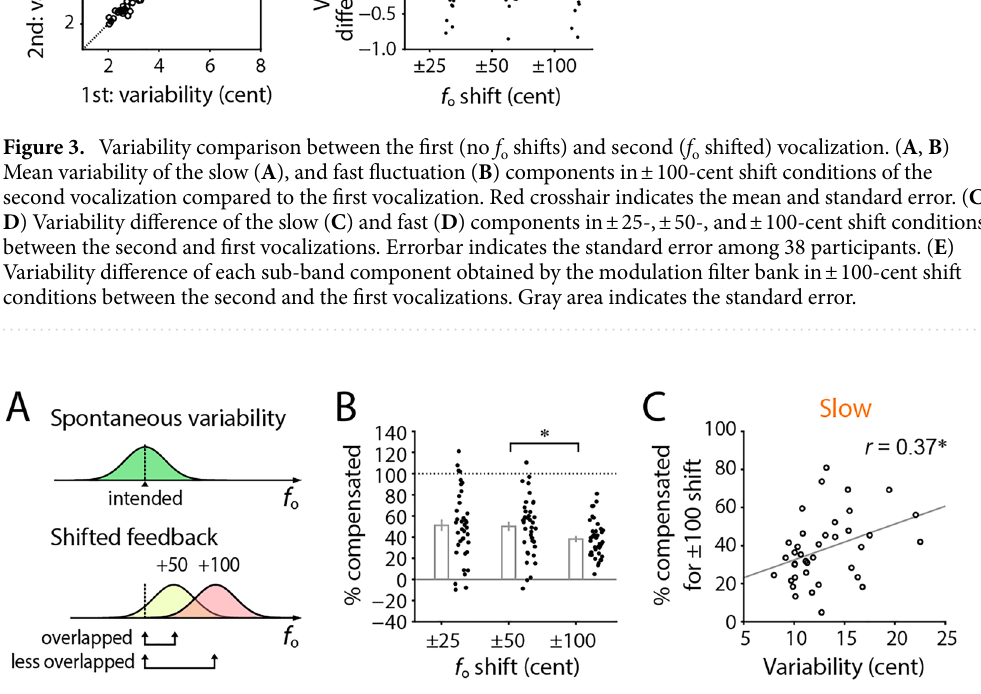
Figure 4. Decreased compensation for larger f o shifts. ( A ) Schematic drawing of normalized distributions for the spontaneous f o variability (upper) and shifted versions of its feedback after the introduction of + 50 and + 100 cent shifts (lower). Given a certain amount of variability, originally intended f o will not overlap well with the distribution for large f o shifts, i.e., the large f o shifts will be outside of the motor exploration range. This can be expected to reduce the compensation ratio for that condition. ( B ) Percent amount of compensatory responses against different amounts of f o shift (25, 50, and 100 cents). The vocal responses to positive f o shifts were sign- inverted and averaged with that to negative shift conditions. Each dot indicates one individual participant. Error bar shows the standard error ( n = 38). Asterisk (*) indicates statistically significant difference ( p < 0.05 in post hoc comparisons with Tukey–Kramer correction). ( C ) Correlation between the compensation ratio for the 100-cent shift amount and the variability of the slow component. r shows Pearson’s correlation coefficient. Two participants who showed negative values in the compensation ratio were excluded as outliers. Asterisk (*) indicates statistically significant correlation ( p <